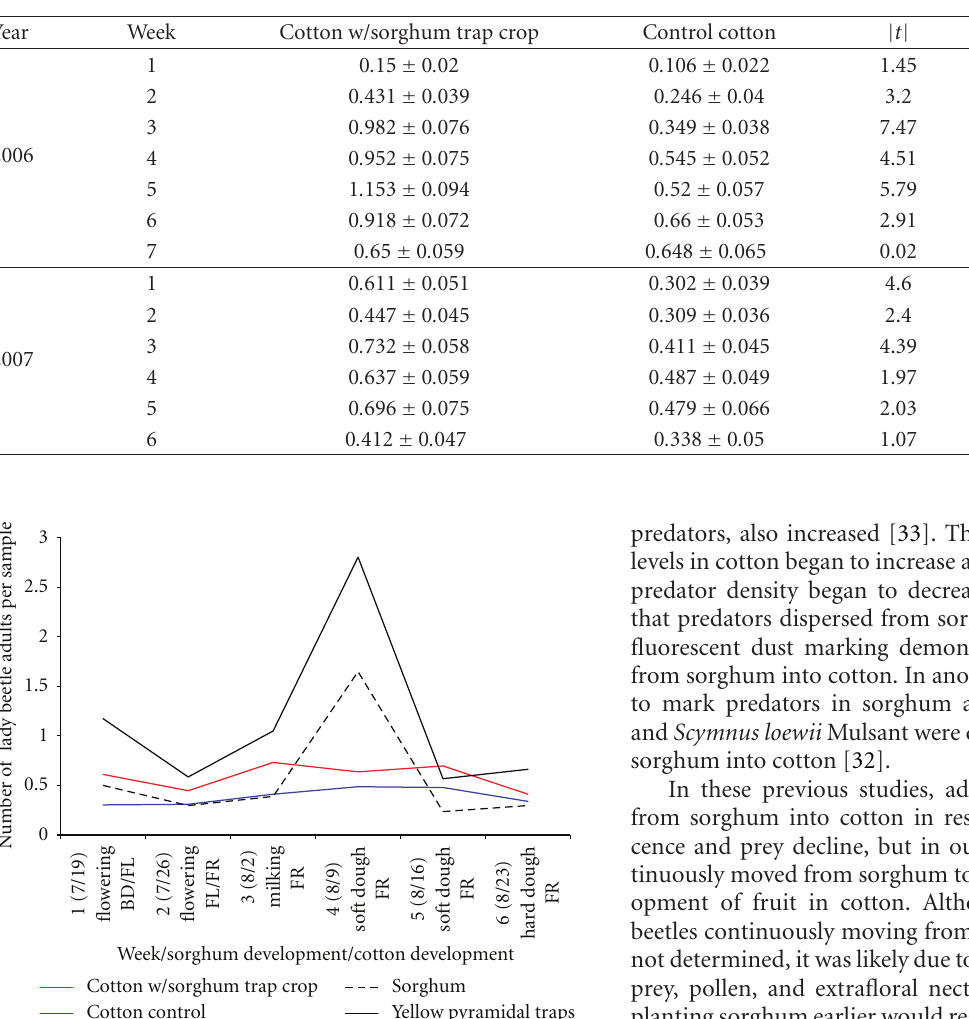
Table 3: Number (mean ± SE) of lady beetle adults per 1.83 m of row in cotton with sorghum trap crops and control cotton in 2006 and 2007.